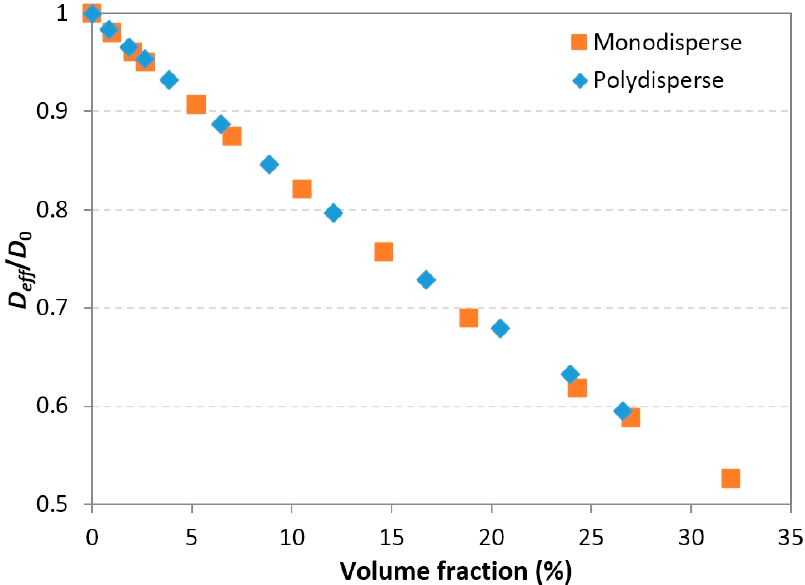
Figure 8. Effects of filler length polydispersity on the relative effective diffusivity (polydisperse: uniform length distribution in the 50–250 nm range, average aspect ratio (cid:2009)(cid:3364) = 4.3 ).